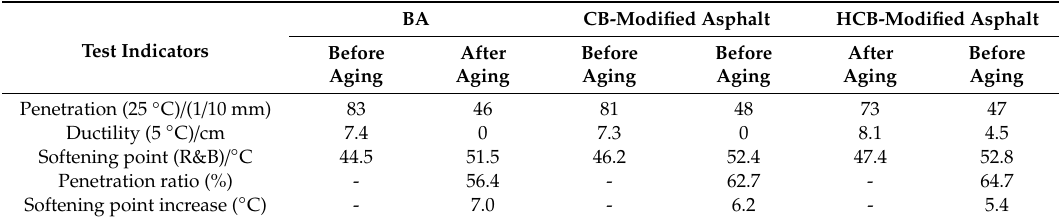
Table 5. Properties of asphalt binders before and after